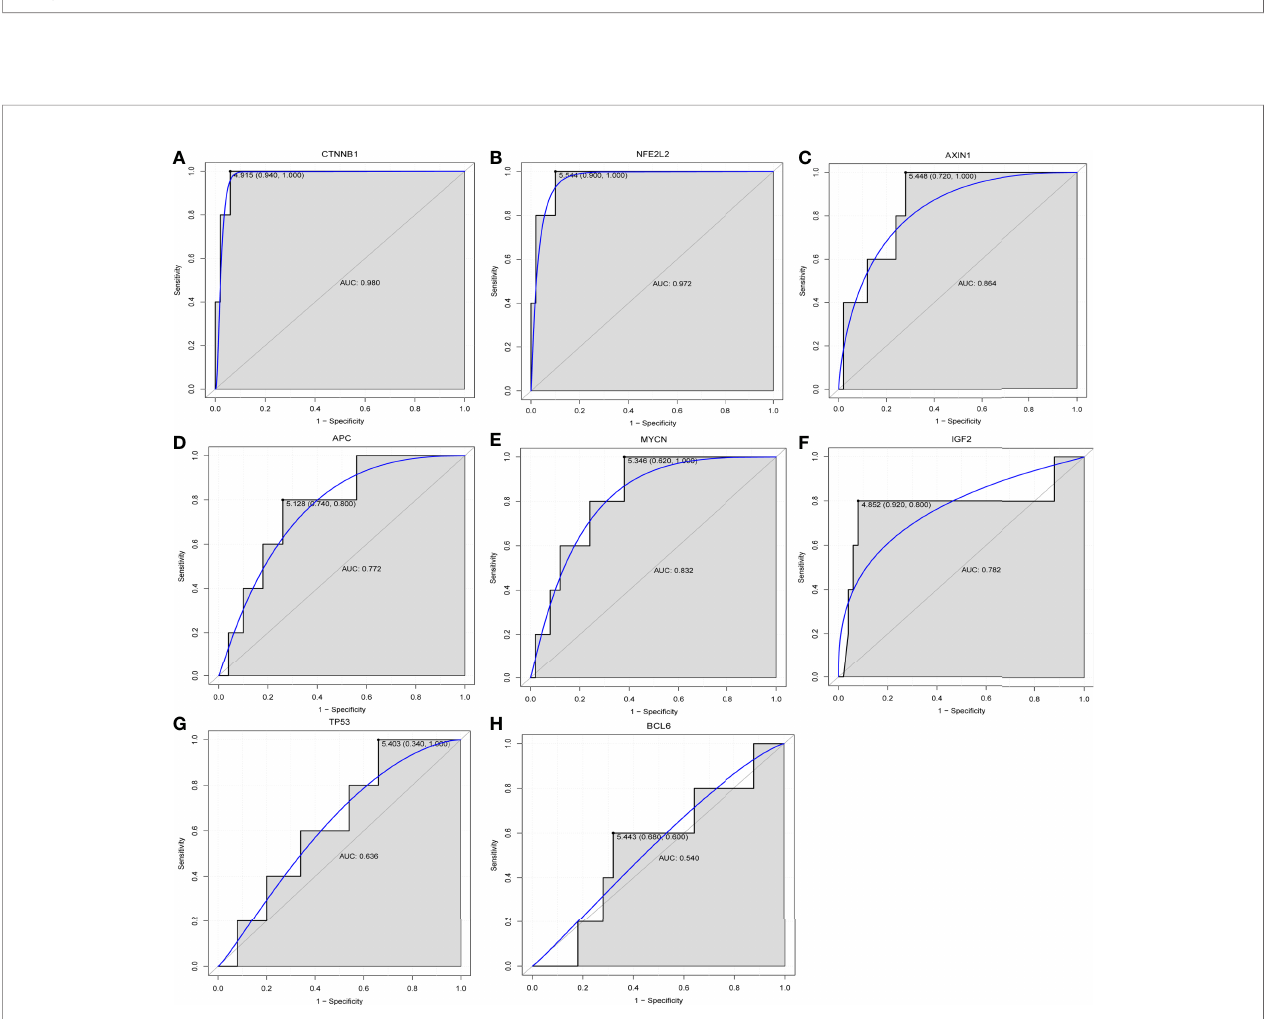
FIGURE 4 | Diagnostic analysis of (A) CTNNB1, (B) NFE2L2, (C) AXIN1, (D) APC, (E) MYCN, (F) IGF2, (G) TP53 and (H) BCL6. CTNNB1, catenin b 1; NFE2L2, factor erythroid 2-related factor 2; AXIN1, axis inhibition protein 1; APC, adenomatous polyposis coli; IGF2, insulin growth factor 2; BCL6, B cell lymphoma 6; AUC, area under